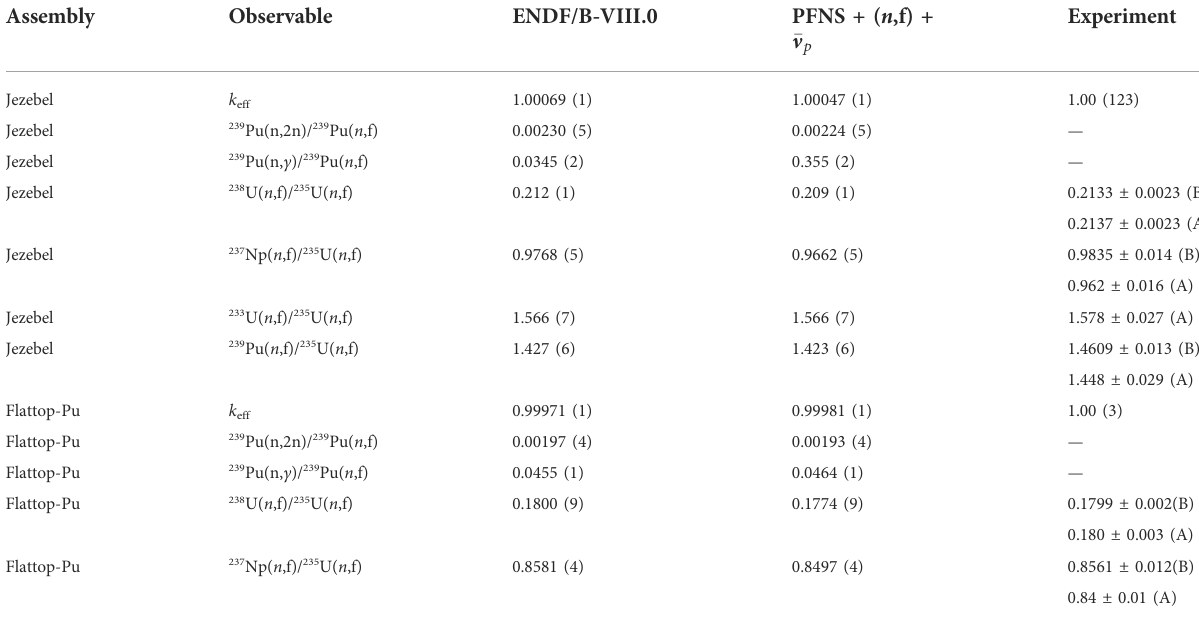
TABLE4Calculatedvaluesareshownfor reactionratesofvariousreactionsinJezebelandFlattop-Pucriticalassemblies.Calculatedvaluesaregiven for ENDF/B-VIII.0 as well as the 239 Pu fi ssion source term. Experimental values were taken from Table XXXIX of Ref. [85].